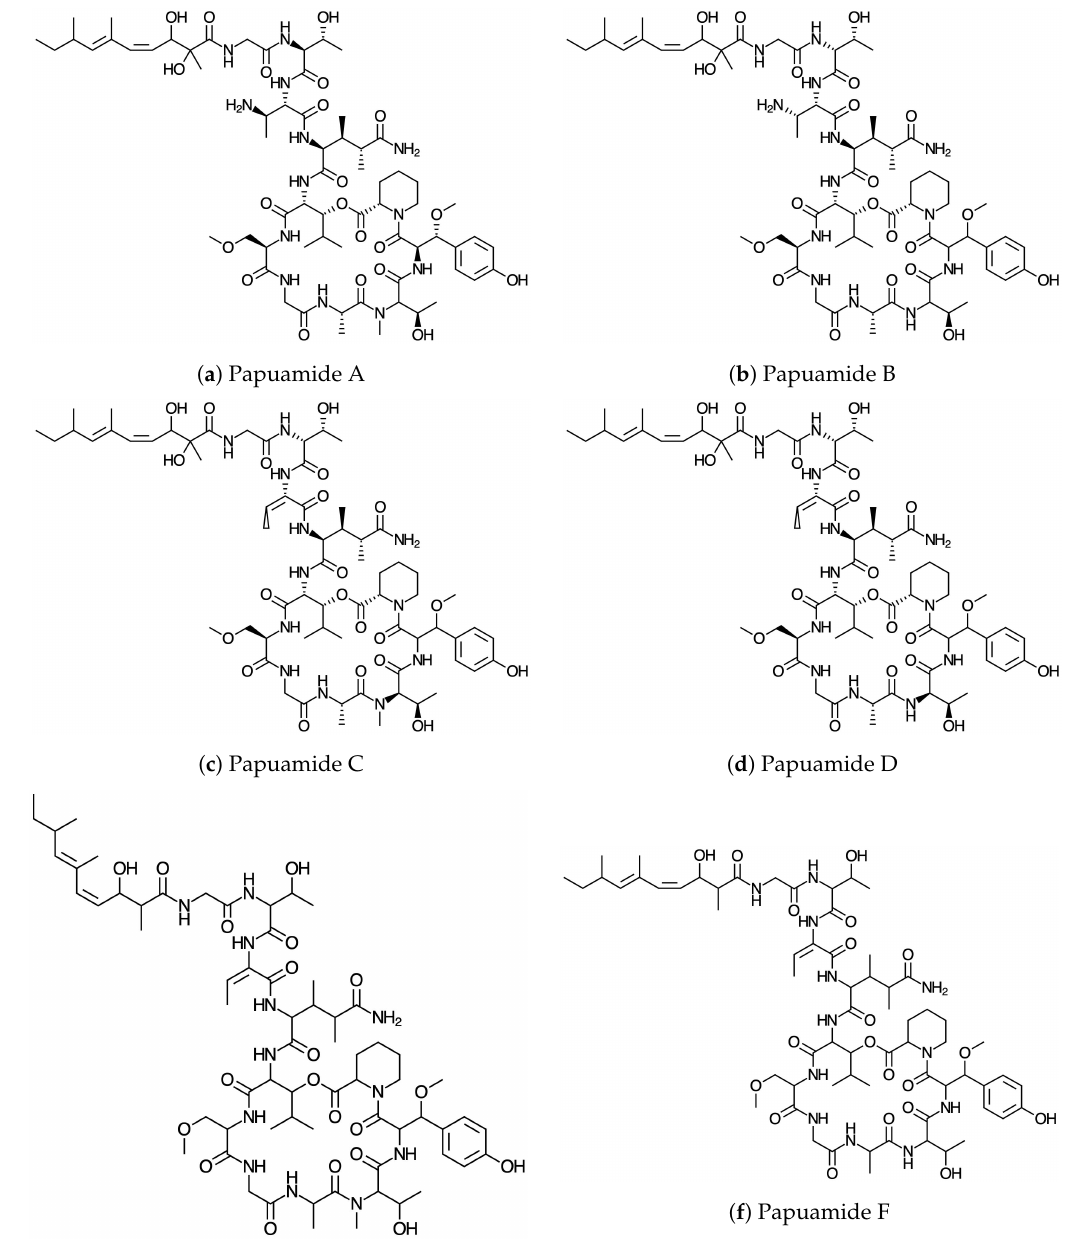
Figure 1. Graphical sketches of the molecular structures of: ( a ) Papuamide A; ( b ) Papuamide B; ( c ) Papuamide C; ( d ) Papuamide D; ( e ) Papuamide E; and ( f ) Papuamide